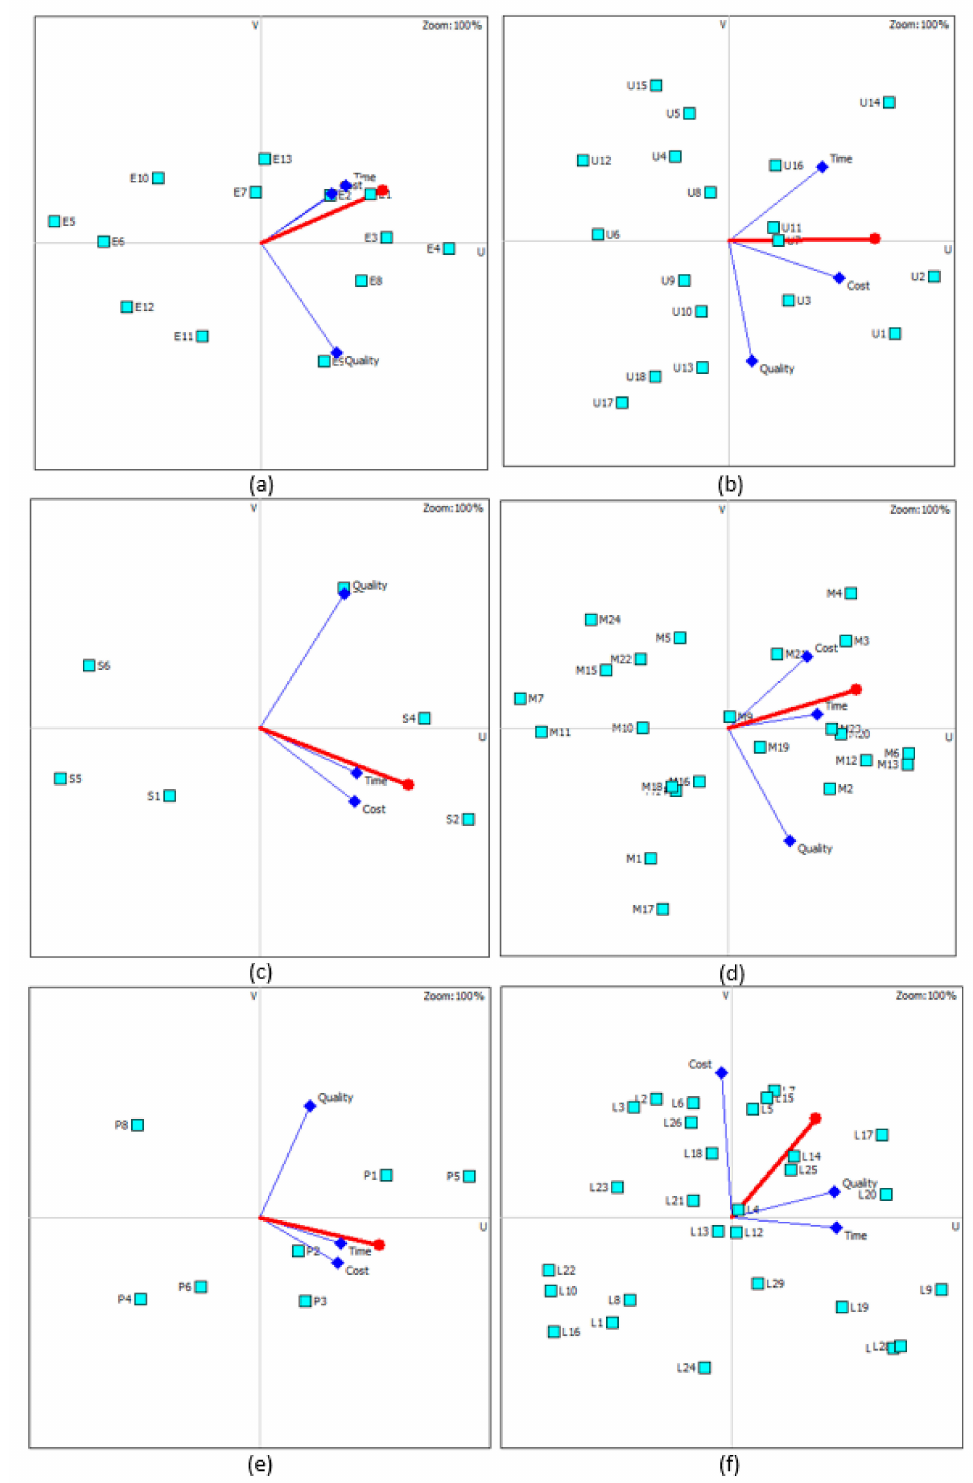
Figure 3. GAIA analysis for ( a ) environmental aspect in healthcare facilities, ( b ) user aspect in healthcare facilities, ( c ) emergency and safety management in healthcare facilities, ( d ) maintenance and repair in healthcare facilities, ( e ) physical aspect of healthcare facilities, and ( f ) lifecycle cost management in healthcare